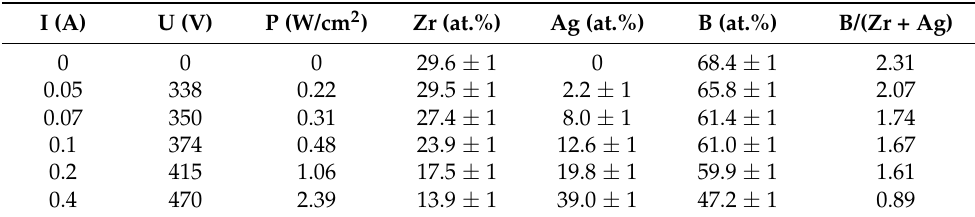
Table 2. WDS quantitative elemental analysis of ZrB 2+ ∆ and Zr 1 − x Ag x B 2+ ∆ films with